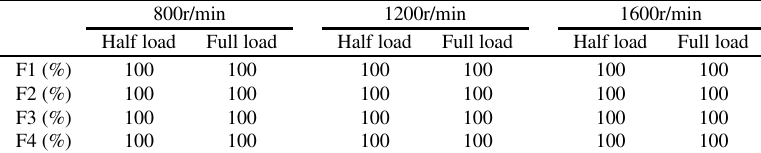
Table 8 The classification success rate with the horizontal vibration signal